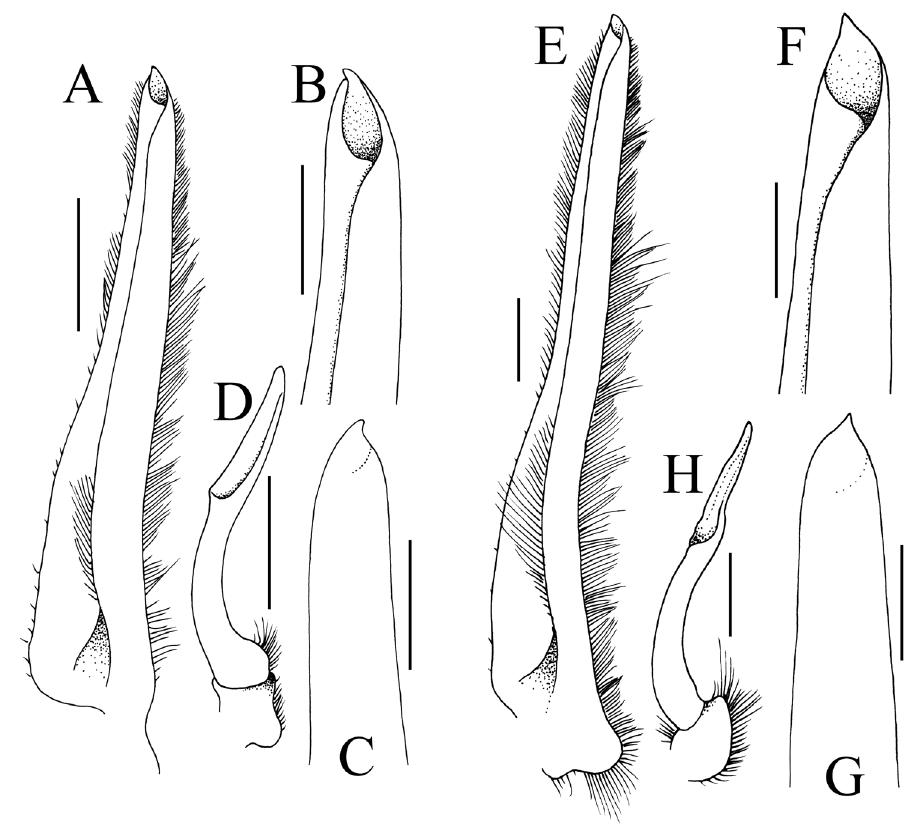
Figure 13. Gonopods. A – D Pariphiculus agariciferus Ihle, 1918, male (15.8 × 15.0 mm) (ZRC), Philip- pines E–H P. stellatus sp. n., holotype male (27.7 × 24.5 mm) (ASIZ 75485), Taiwan. A–C, E–G left G1 D, H left G2. Scale bars A, E, D, H 1.0 mm; B, C, F, G 0.5